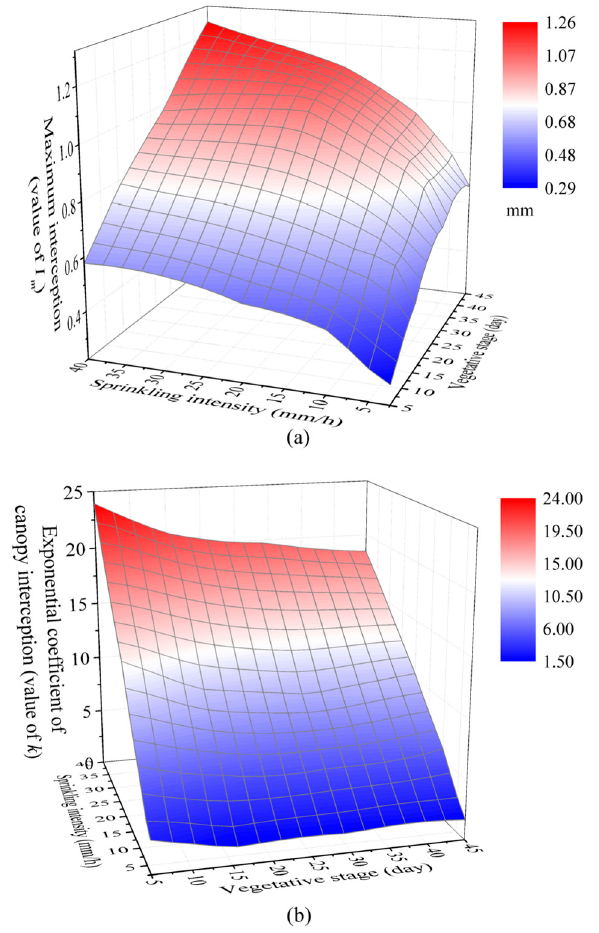
Figure 4. Variation tendencies of model coefficients I m ( a ) and k ( b ) with the variations of sprinkling intensities and vegetative stages (days after the most recent harvest of alfalfa). I m is the maximum interception, and k is the exponential coefficient of the canopy interception.